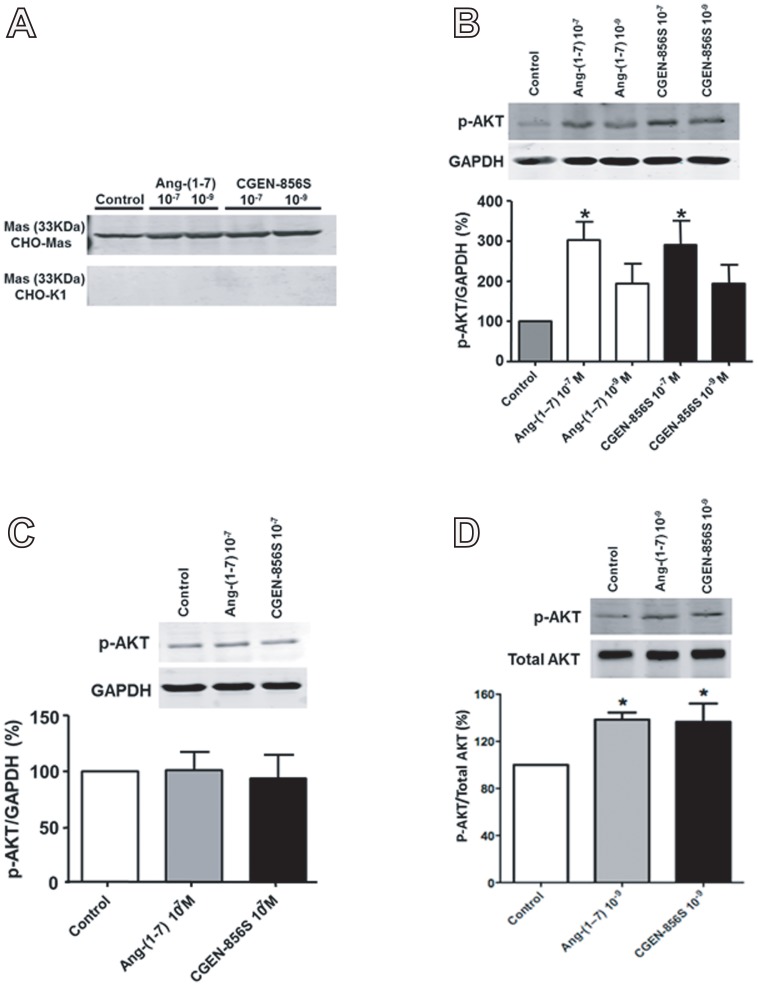
Effects of CGEN-856S and Ang-(1–7) administration on AKT phosphorylation and on the quantity of p-AKT.(A) Representative immunoblots demonstrating the presence of Mas in Mas-transfected CHO cells (CHO-Mas) and the absence of Mas in untransfected cells (CHO-K1). (B) Effects of CGEN-856S and Ang-(1–7) administration (10−9 and 10−7 mol/L) for 10 min on p-AKT levels in CHO-Mas cells. (C) The absence of effects of CGEN-856S and Ang-(1–7) administration (10−7 mol/L) for 10 min on p-AKT levels in CHO-K1 cells. (D) Effects of CGEN-856S and Ang-(1–7) administration (10−9 mol/L) for 5 min on AKT phosphorylation in CHO-Mas cells. Ang-(1–7) (10−9 and 10−7 mol/L) was used as a positive control and glyceraldehyde 3-phosphate dehydrogenase (GAPDH) and total AKT were used as loading controls. *P<0.05 vs. control. Results are expressed as the mean ± SEM of 4−6 experiments.